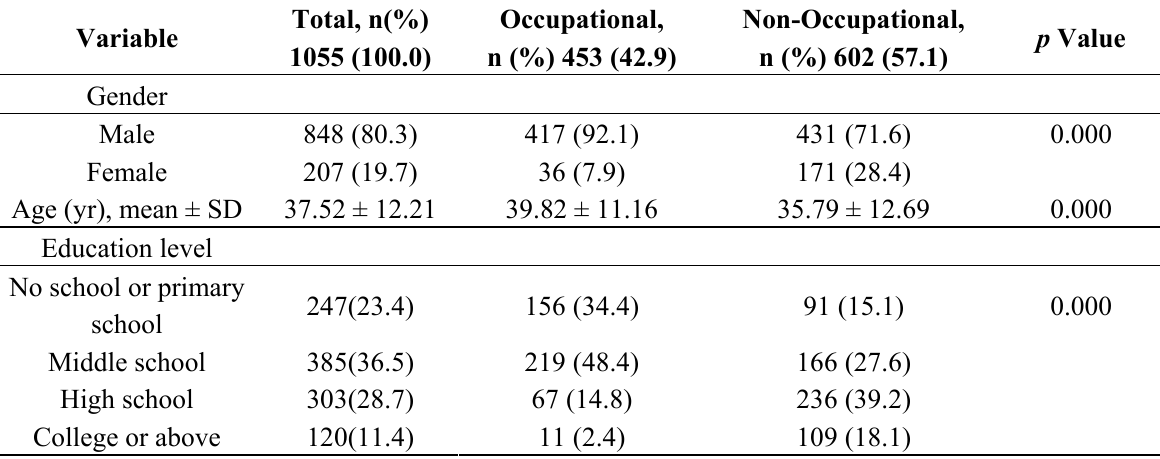
Table 1. Demographic characteristics of occupational and non-occupational eye